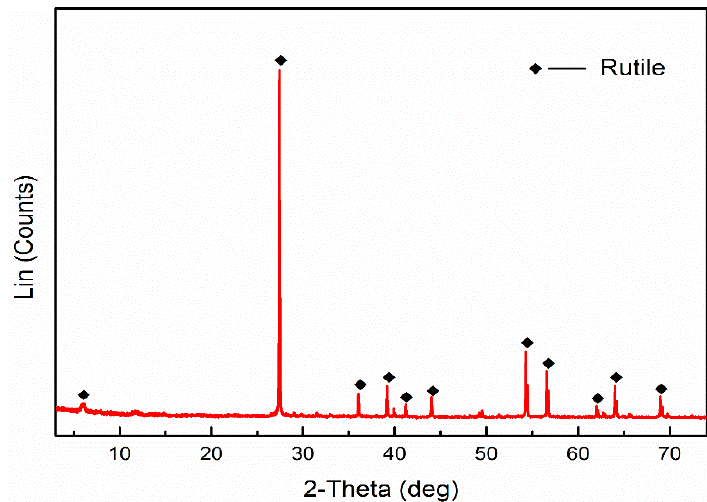
Figure 1. XRD pattern of the rutile. Table 1. Multi ‐ element analysis of the pure rutile mineral (%).